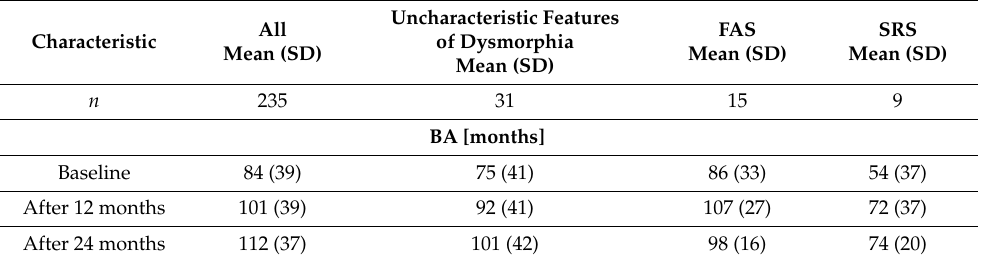
Table 7. Bone age, difference between calendar age and bone age, bone age/calendar age ratio in different